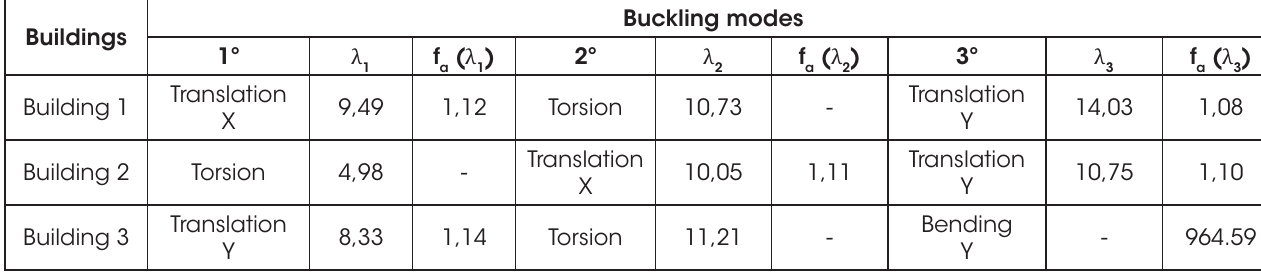
Results of the elastic stability analysis